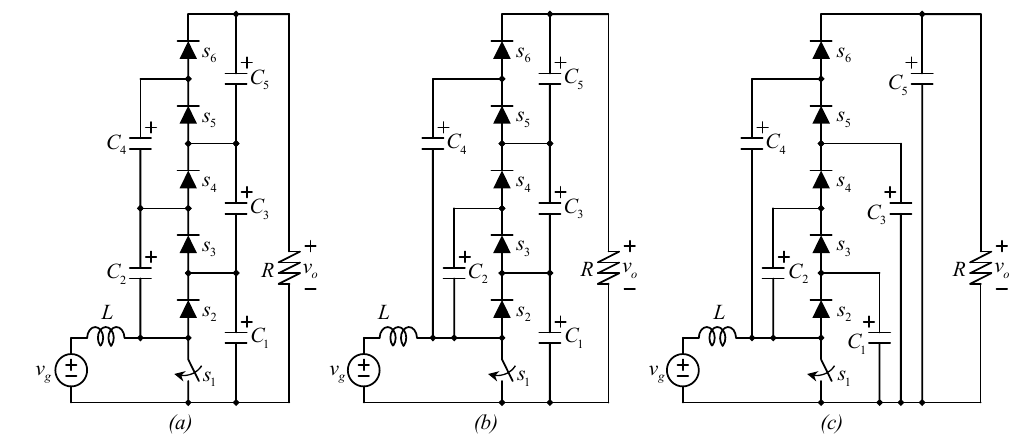
Figure 26. The Multilevel boost converter: ( a ) topology studied in [51], ( b ) topology studied in [52], ( c ) topology studied in [41].